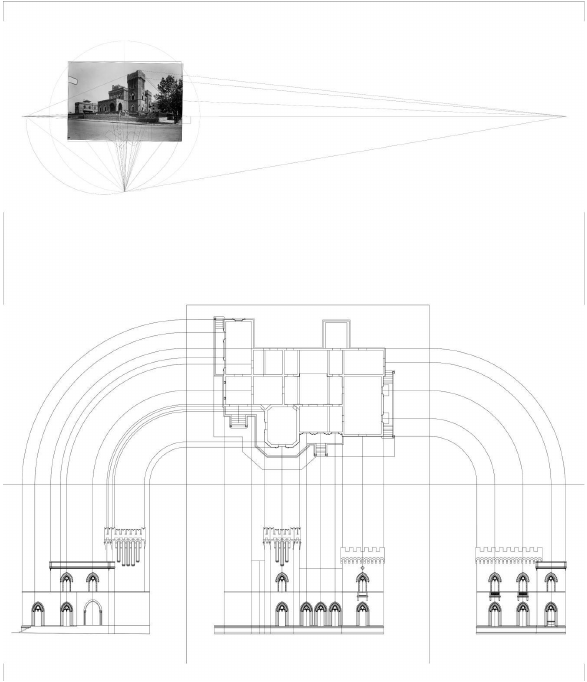
Figure 3 . Perspective reconstruction using photos